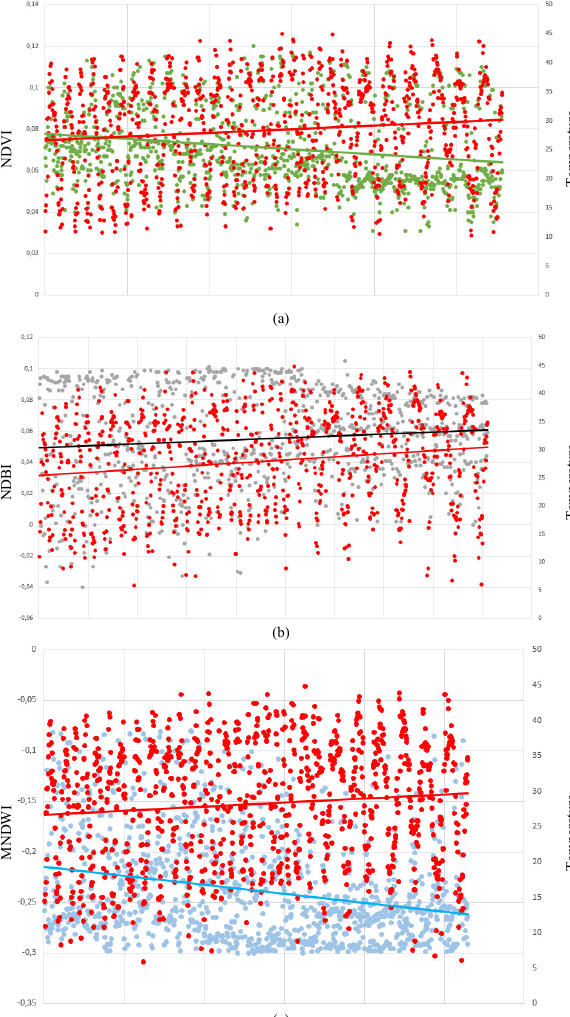
Figure 2. Statistical visualization of mean values acquired based on Landsat imagery during the 30 years for the city of Cairo. (a) Relationship between temperature and NDVI, (b) the relationship between temperature and NDBI and (c) the relationship between temperature and MNDWI.